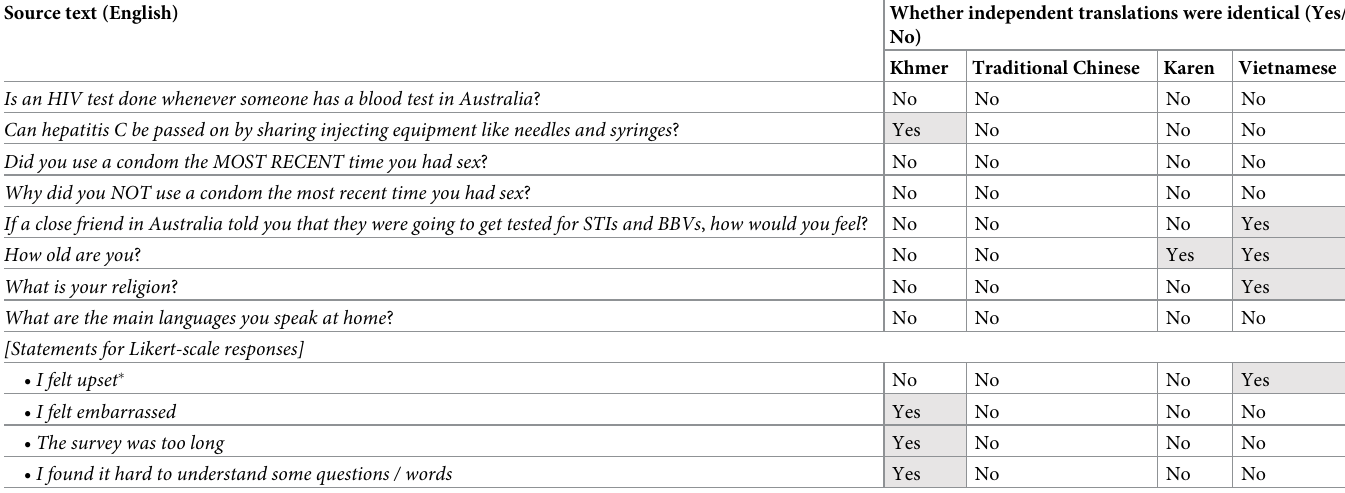
Table 3. Identical independent translations of substantive English-language survey questions, by language of translation. Source text